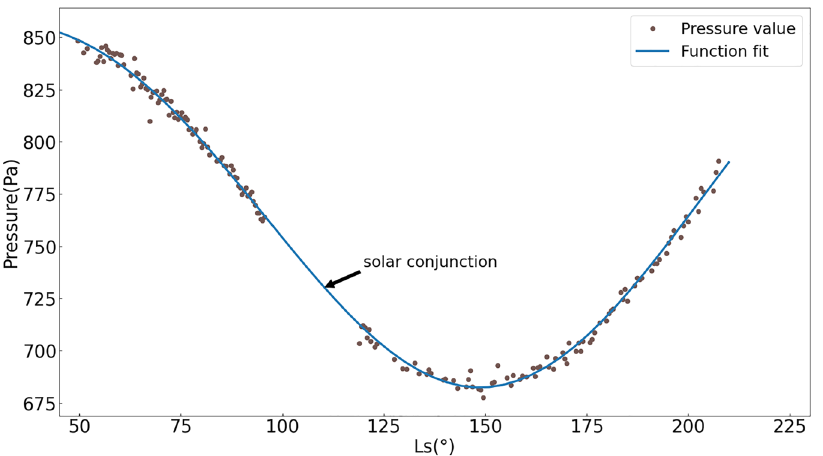
Figure 3. Pressure fit using a trigonometric function. The figure shows an obvious trend with the season. Each point is an average value in one sol to prevent bias from the fact that there may be a significantly different number of measurements taken at different times of a sol. The Zhurong rover and the Tianwen-1 orbiter work in a safe mode and stop collecting data during the solar conjunction, and this leads to a blank of 50 sols. Blue curve is the one fitted by the data of about 12 months. Real pressure points distribute just nearby the line.